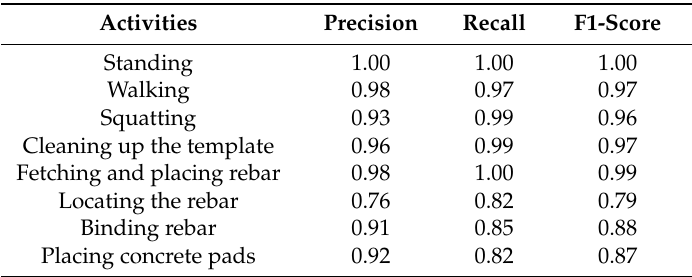
Table 5. Result of eight activities’